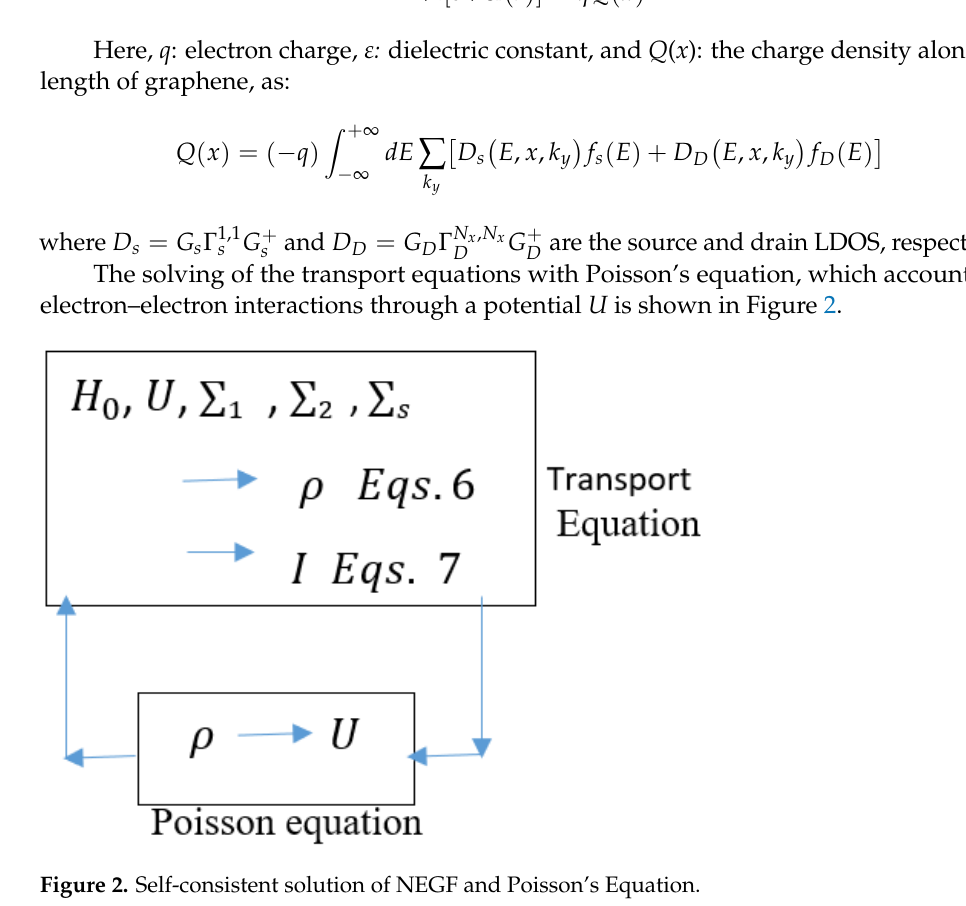
Figure 2. Self- consistent solution of NEGF and Poisson’s Equation. Figure 2. Self-consistent solution of NEGF and Poisson’s